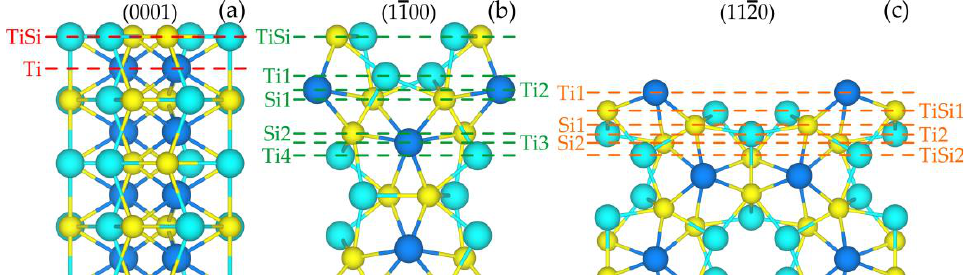
Figure 2. Atomic structure of the low-index surfaces ( a ) (0001), ( b ) (1100) and ( c ) (1120 ) (side view) of the compound Ti 5 Si 3 .